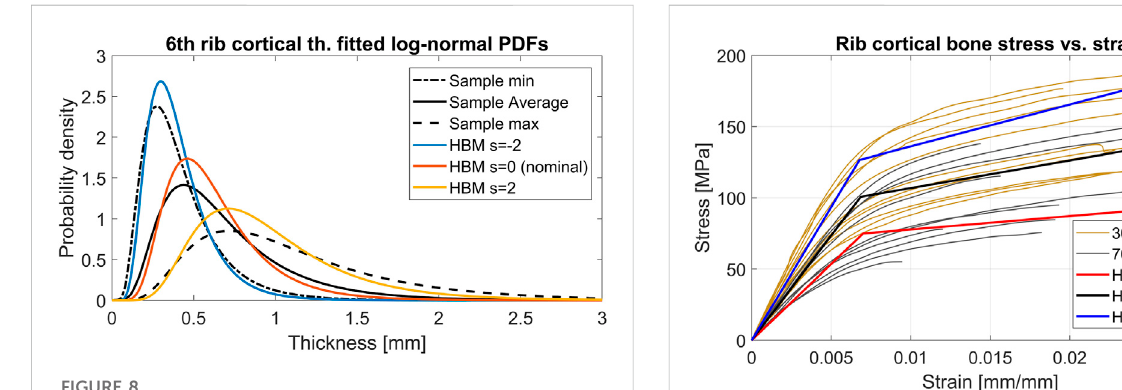
FIGURE 8 Probability density functions of sixth rib cortical bone thickness. Black curves correspond to the overall thinnest, average, and thickest individual bones in the Holcombe et al. (2019) n = 33 sample. Blue, orange, and yellow curves demonstrate the distribution of cortical bone thickness in the SHBM for s = − 2, s = 0 and s = 2, respectively.